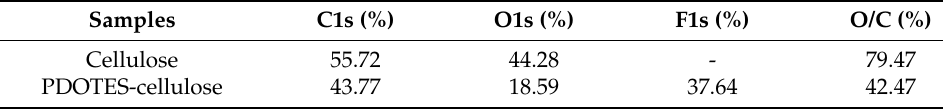
Table 1. Cellulose surface element